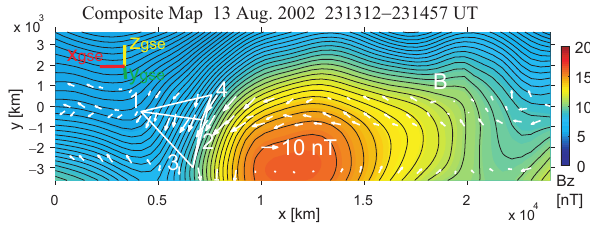
Fig. 34. Magnetic field map reconstructed from Cluster observa- tions of a bipolar − / + B z signature on 13 August 2002, 23:13:12– 23:14:57UT. Black lines show magnetic field lines transverse to the invariant ( z ) axis, while colors show the out-of-plane field compo- nent. Measured field vectors are represented by white arrows and projected onto the reconstruction ( x − y ) plane along the four space- craft paths. The spacecraft move from left to right in the map. The optimally selected GS axes are in GSE: x = ( − 0 . 998 , 0 . 052 , 0 . 019 ) , y = ( − 0 . 018 , − 0 . 635 , 0 . 773 ) , and z = ( 0 . 052 , 0 . 771 , 0 . 635 )